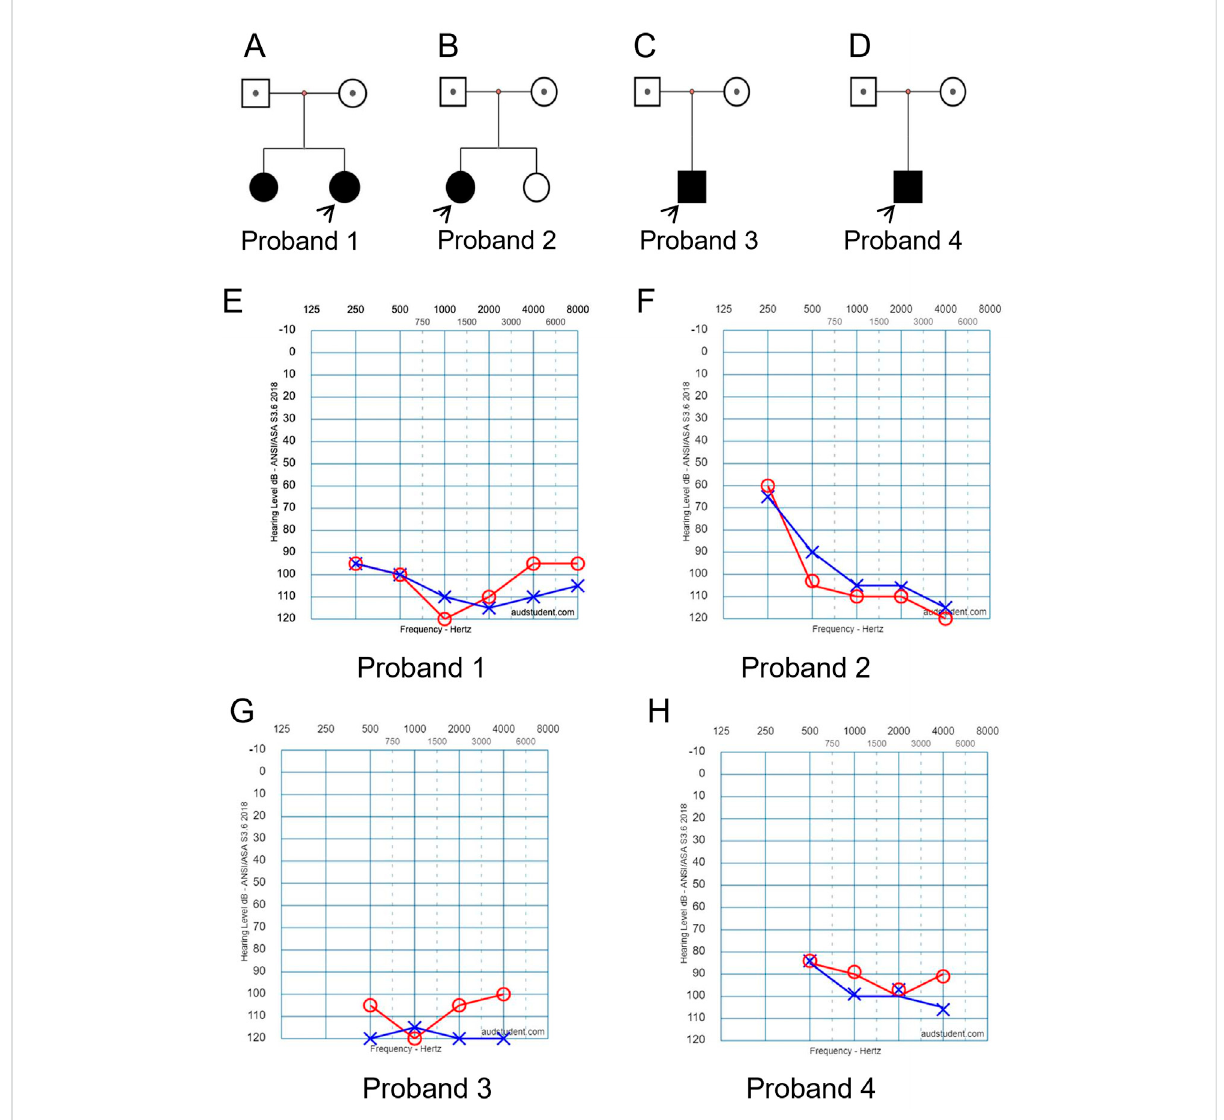
FIGURE 1 Clinical fi ndingsofaffectedfourfamilies. (A – D) Familytrees.Probandsareindicatedbyarrows. (E – H) Puretoneaudiometryexaminationsshow bilateral severe sensorineural hearing loss for the affected probands 1 to 4,